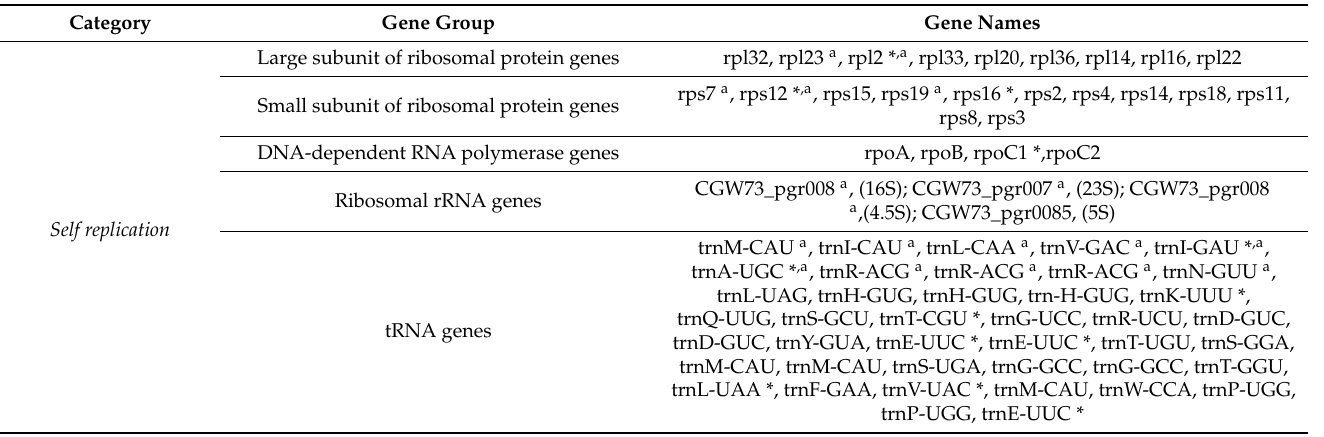
Table 2. Functions of genes identified from the P. vera chloroplast